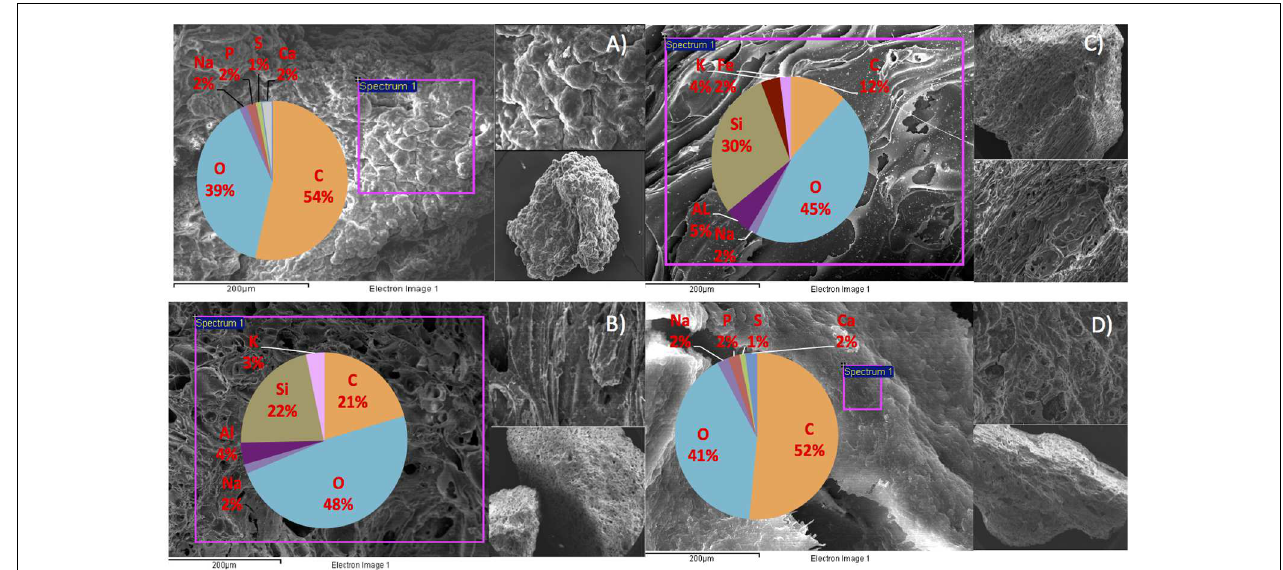
FIGURE 1 | SEM/EDX images and element composition of reactor contents at the end of the trial (A) sludge granule, (B) unused pumice stone, (C) washed pumice stone and (D) biomass on the pumice stone.